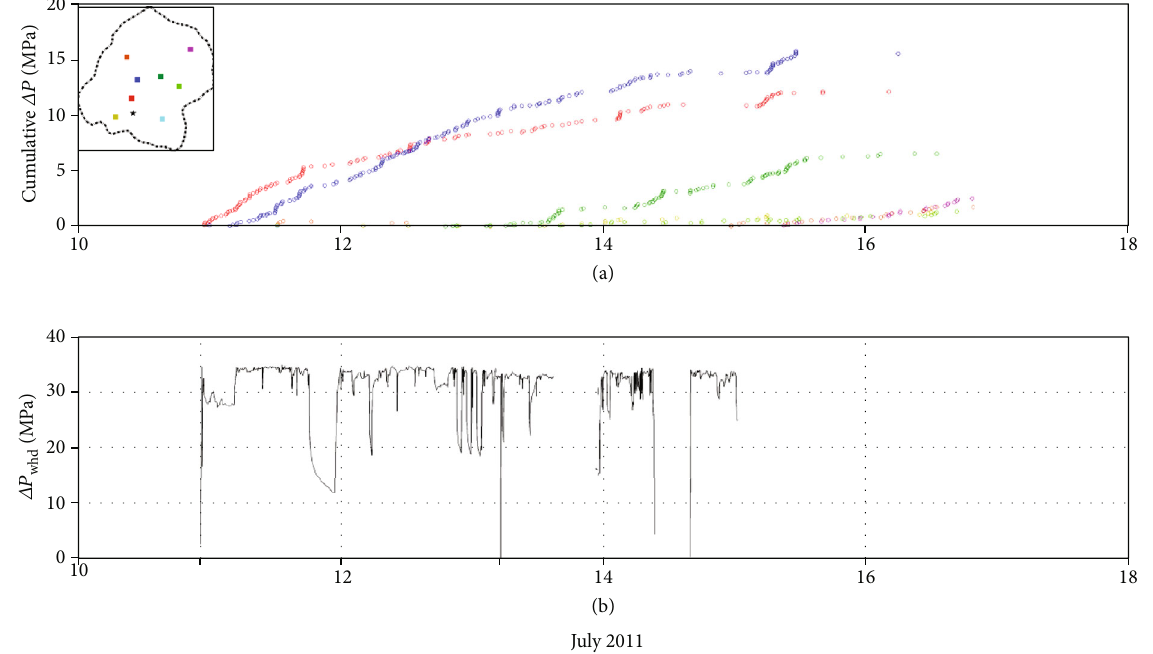
Figure 11: (a) Temporal evolution of cumulative fl uid pressure changes determined from overlapping slips at the 8 locations in the reservoir indicated by corresponding colours in the small fi gure inset. A constant stress drop of 0.1MPa is assumed. Contour line in the fi gure inset denotes the main region of seismic activity after projection and rotation operations. The black star denotes the injection point of the well Paralana-2. (b) Temporal evolution of the pressure changes Δ P whd measured at the wellhead of Paralana-2 during the main stimulation in July 2011. Pressure changes were determined by subtracting the initial overpressure of 27 MPa from pressure